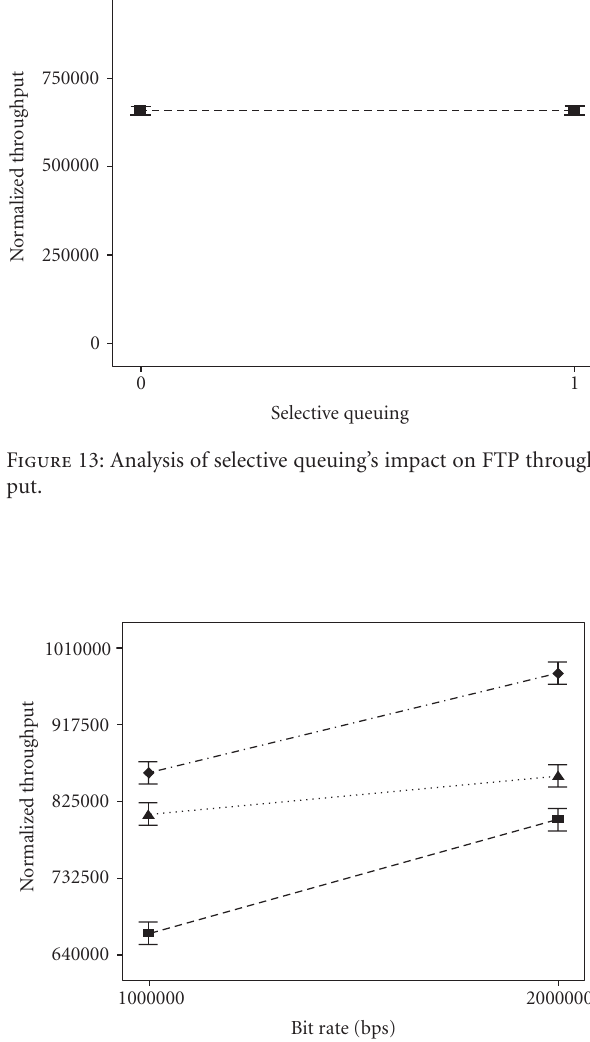
(the worst case being an average latency of 1.36 seconds and the best being 0.00937 seconds). This o ff ers an impressive ex-